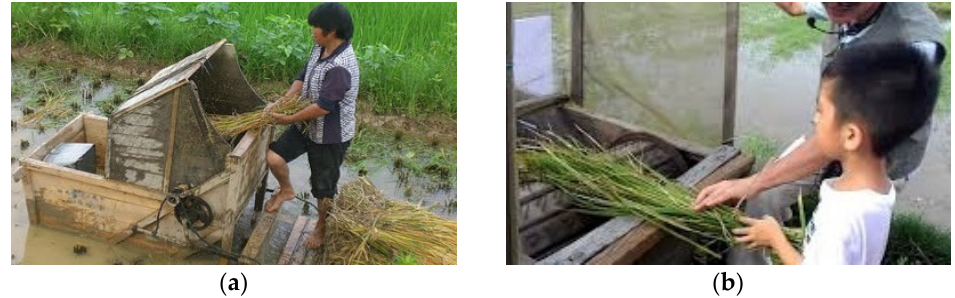
Figure 2. Real old-time pedal-operated rice threshing machines. ( a ) A machine with a complete view [73]. ( b ) Another machine with a closer view [74] (Note: the rice grains are removed away from the rice ears by a roller with nails on the surface, whose rotation is controlled by a pedal stepped on by the farmer).